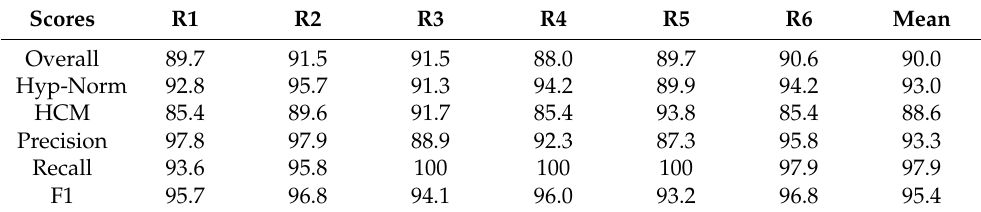
Table 2. The scores of the human evaluation. The scores are consistent across the readers; the variance is